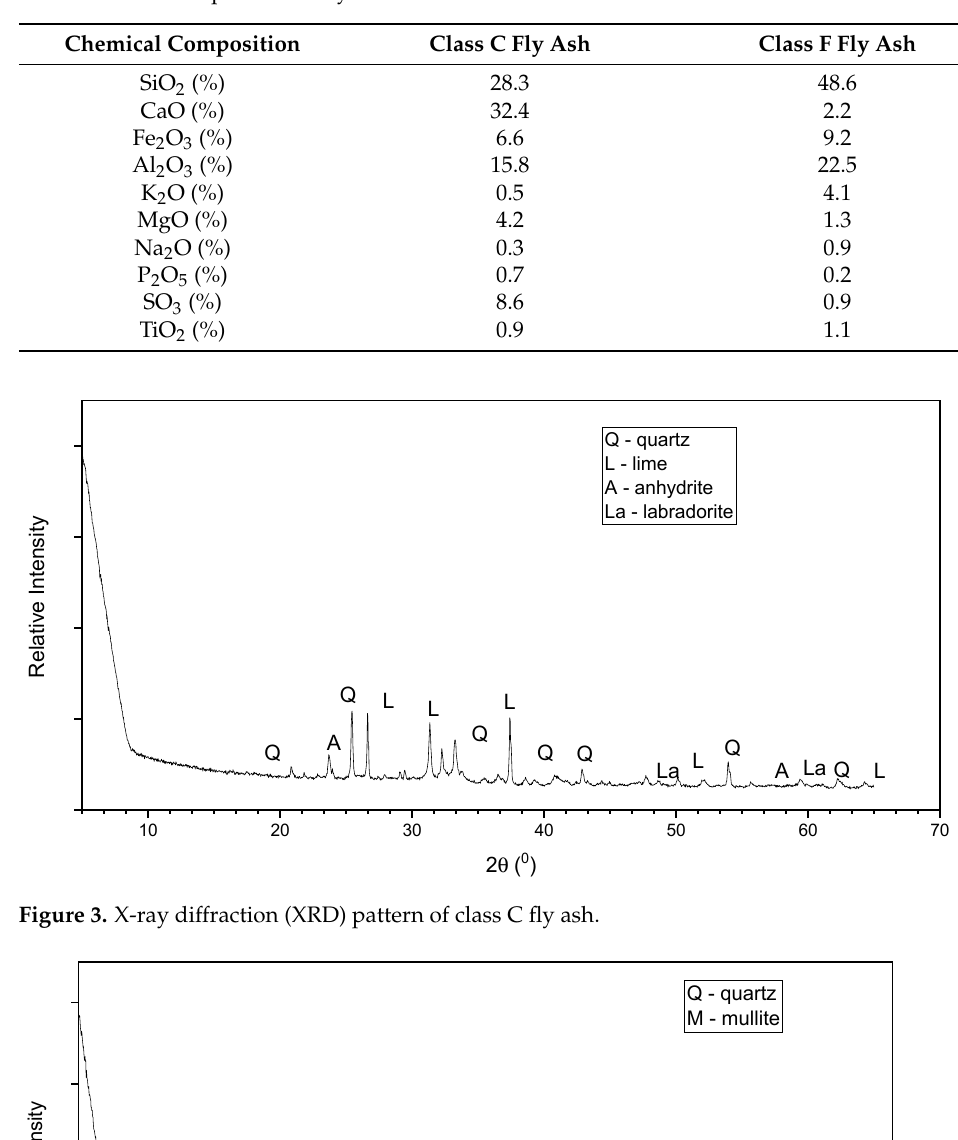
Table 2. Oxide composition of fly ashes.